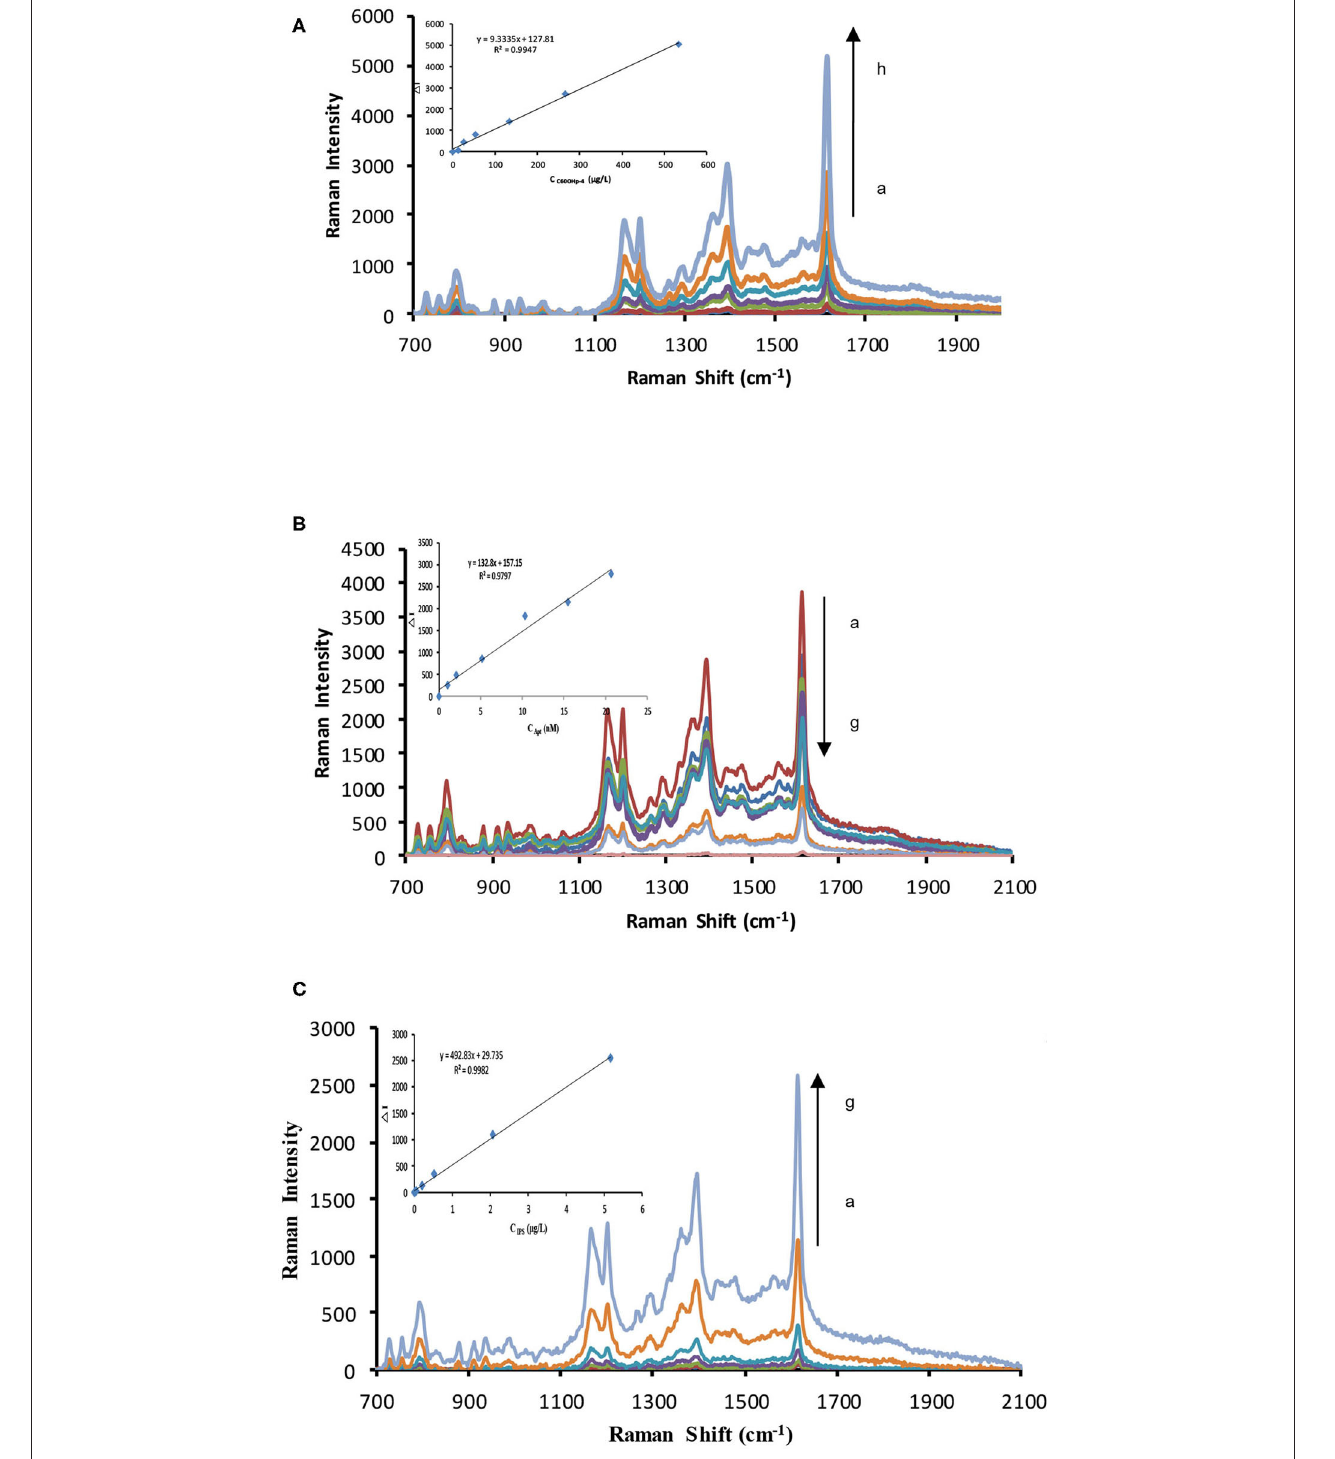
FIGURE 2 | SERS spectra. (A) C 60 OH–AgNO 3 -TSC catalytic system. (0, 2.67, 5.33, 13.33, 26.67, 53.33, 133.33, 266.67, 533.33 µ g/L) C 60 OH 4 + 1.33 mmol/L AgNO 3 + 4.67 mmol/L TSC + 85 ◦ C + 21min + 3.33 × 10 − 7 mol/L VBB + 0.02 mol/L NaCl. (B) Apt–C 60 OH–AgNO 3 -TSC inhibitory catalytic system. (0, 1.03, 2.07, 5.17, 10.33, 15.5, 20.67 nmol/L) Apt + 266.67 µ g/L C 60 OH + 21min + 1.33 mmol/L AgNO 3 + 4.67 mmol/L TSC + 85 ◦ C + 3.33 × 10 − 7 mol/L VBB + 0.02 mol/L NaCl. (C) Apt–C 60 OH–AgNO 3 -TSC-IPS detection system. 20.67 nmol/L Apt + 266.67 µ g/L C 60 OH + (0, 0.02, 0.05, 0.21, 0.52, 2.07, 5.17 µ g/L) IPS + 1.33 mmol/L AgNO 3 + 4.67 mmol/L TSC + 85 ◦ C + 21min + 3.33 × 10 − 7 mol/L VBB + 0.02 mol/L NaCl.